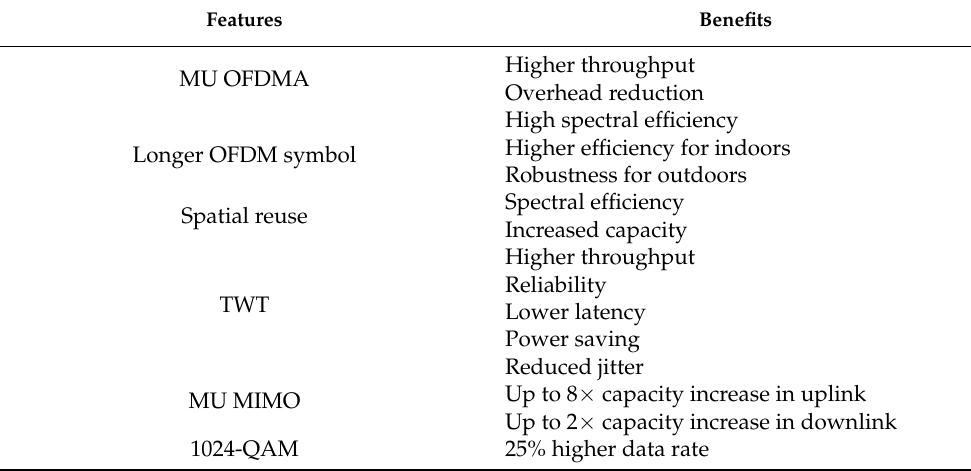
Table 5. Innovations in Wi-Fi